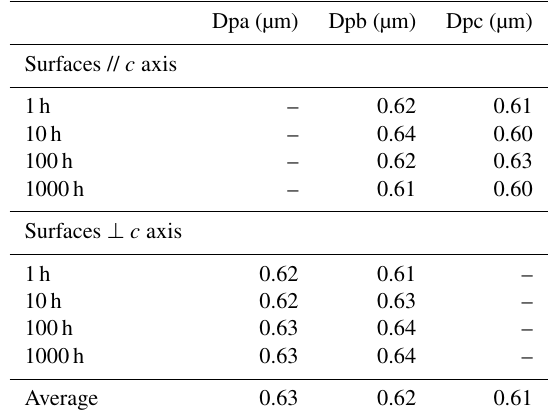
Table 2. Average diameters of implanted 252 Cf fission track open- ings on both parallel and perpendicular surfaces for each annealing